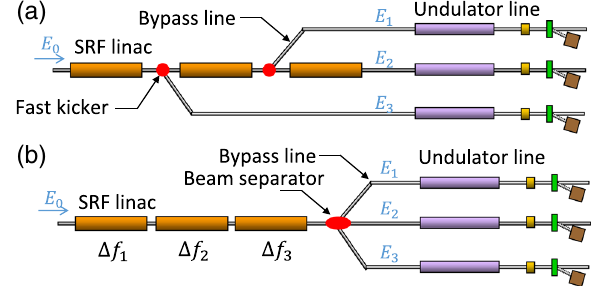
FIG. 1. Two schemes of multi-energy operation of a SRF XFEL: (a) kick the beam to bypass line at desired energy point (b) control the beam energy independently by off-frequency detune of SRF